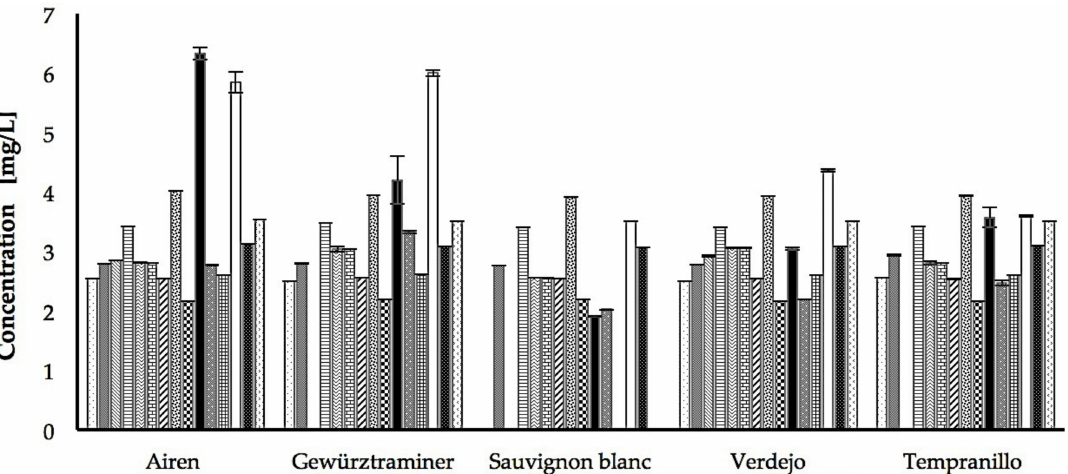
Figure 2. Comparison of the 15 polyphenols identified by LC-MS/MS in the grape juice extracts of Vitis vinifera var. Airen, Gewürztraminer, Sauvignon Blanc, Verdejo and Tempranillo. Caffeic acid ( ), chlorogenic acid ( ), coumaric acid ( ), dihydroxibenzoic acid ( ), gallic acid ( ), protocatechuic acid ( ), salicylic acid ( ), vanillic acid ( ), esculetin ( ), catechin ( ), epicatechin ( ), isorhamnetin ( ), quercetin ( ), polydatin ( ), resveratrol (